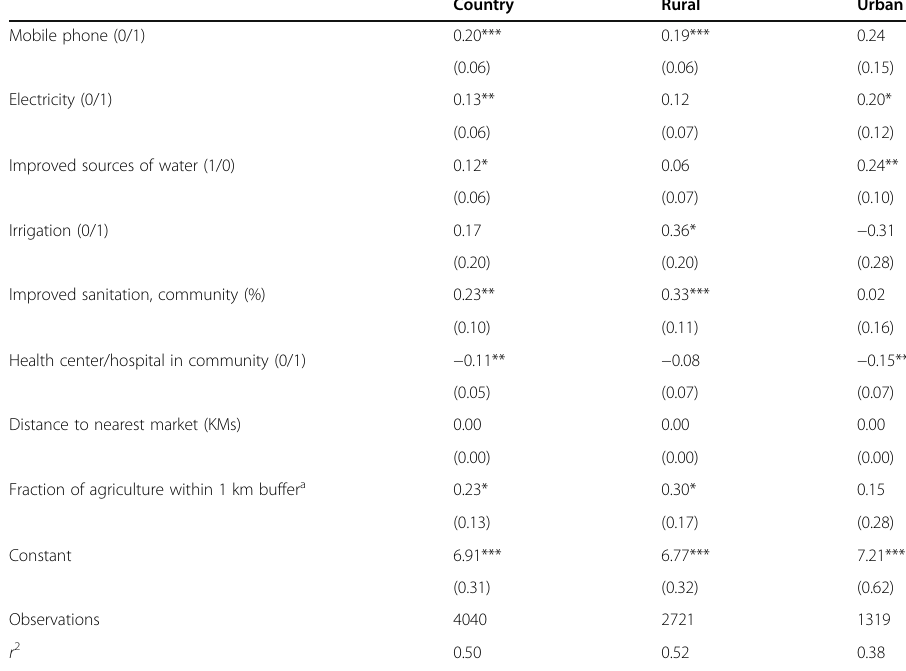
Table 2 Correlates of household dietary diversity